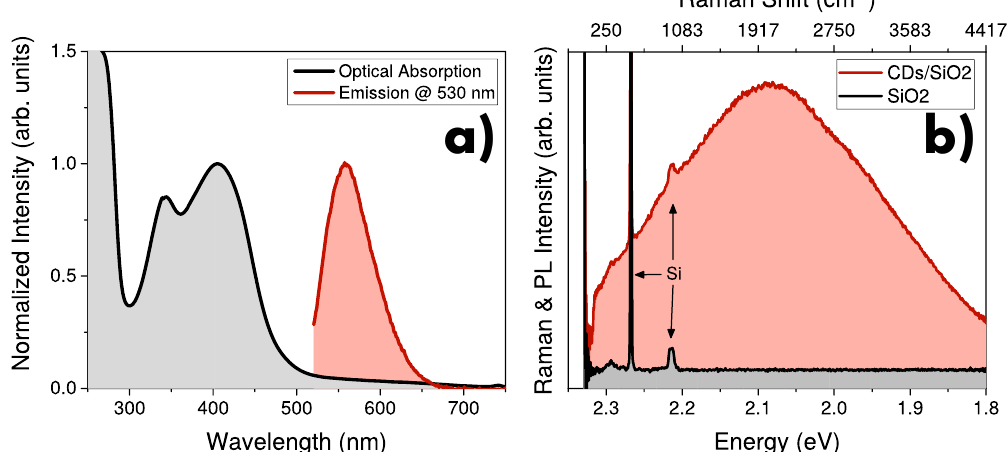
Figure 1. ( a ) Optical absorption (black) and photoluminescence (PL) emission excited at 530 nm (red) of ethanol-dispersed carbon dots (CDs). ( b ) µ -Raman/PL spectra of CDs deposited on SiO 2 /Si substrate (red) and bare substrate (black). Raman bands of silicon are highlighted by arrows.